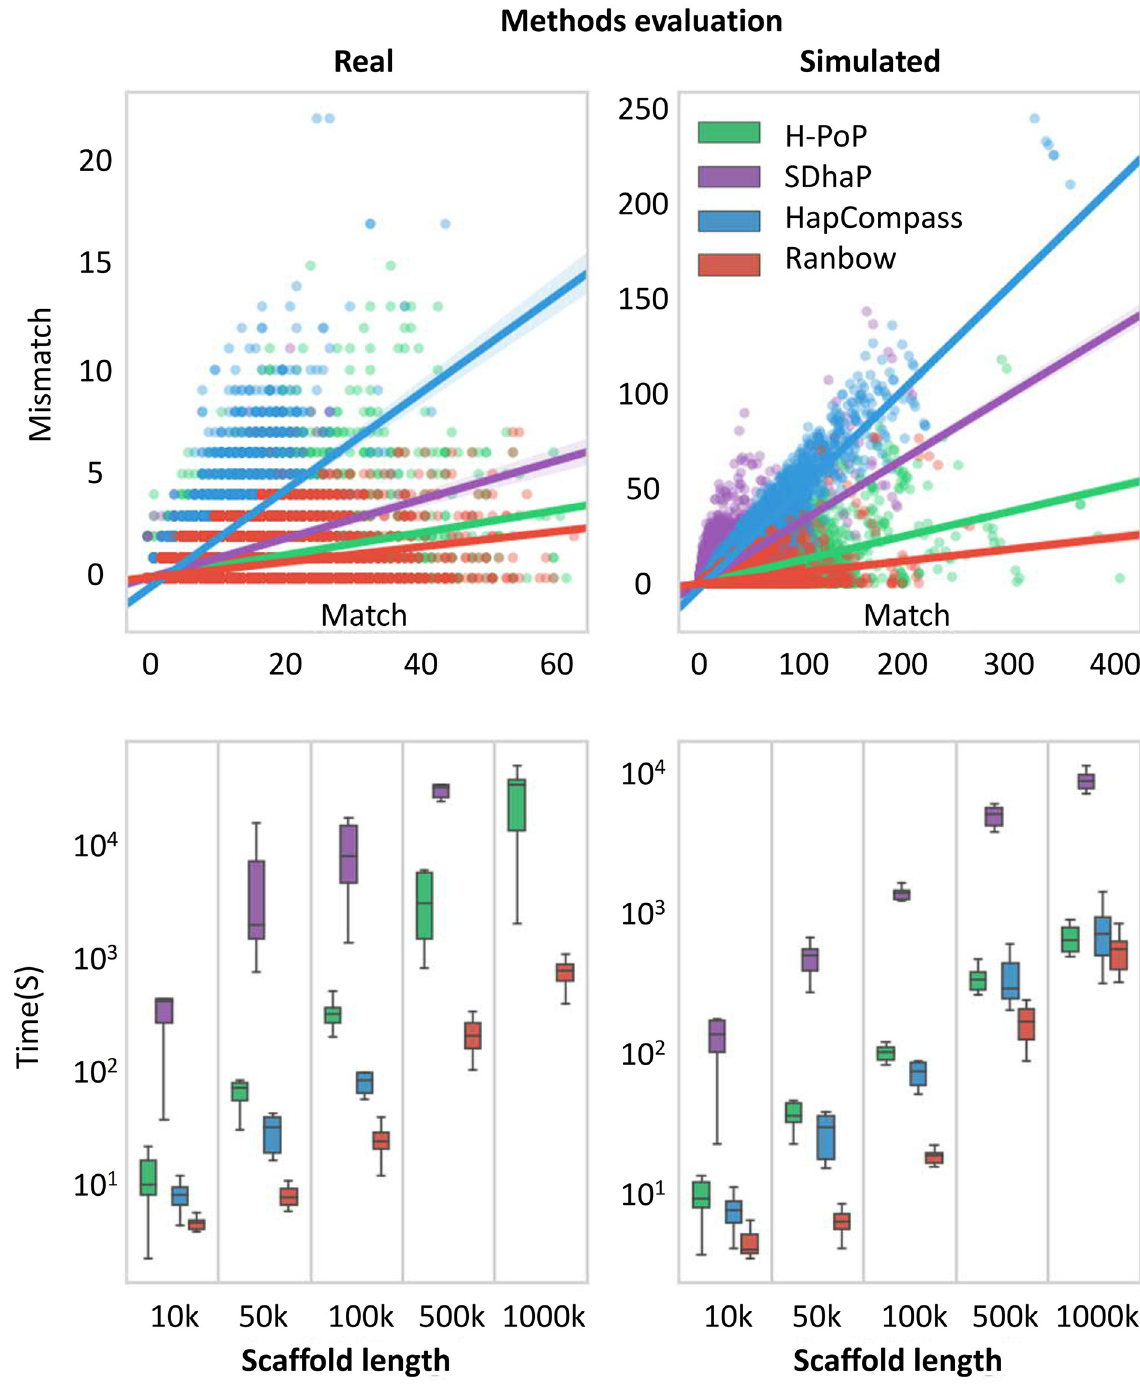
Fig 5. Comparison of all methods on sweet potato real and simulated datasets. A, B) Match-mismatch plots for sweet potato real and simulated datasets, respectively. These scatter plots illustrate the accuracy of the methods. C, D) The execution time s for different scaffold size groups (10 scaffolds per five scaffold length groups, totally 10 × 5 scaffolds). The y-axis is in logarithmic scale.